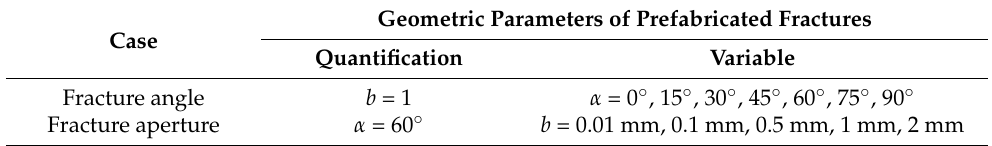
Table 3. Combinations of the different fracture parameters used to reflect the fracture morphology.